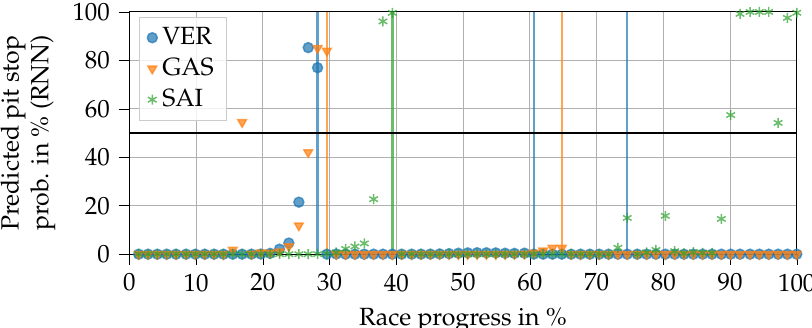
Figure 7. Progressions of pit stop probabilities for three drivers predicted by a recurrent NN (RNN) using real input data from the 2019 Brazilian Grand Prix. The vertical lines indicate that a real pit stop was made by the respective driver. The horizontal line at 50% probability separates the no pit stop from the pit stop region. The race was excluded from the training data. Driver abbreviations: VER—Verstappen, GAS—Gasly,